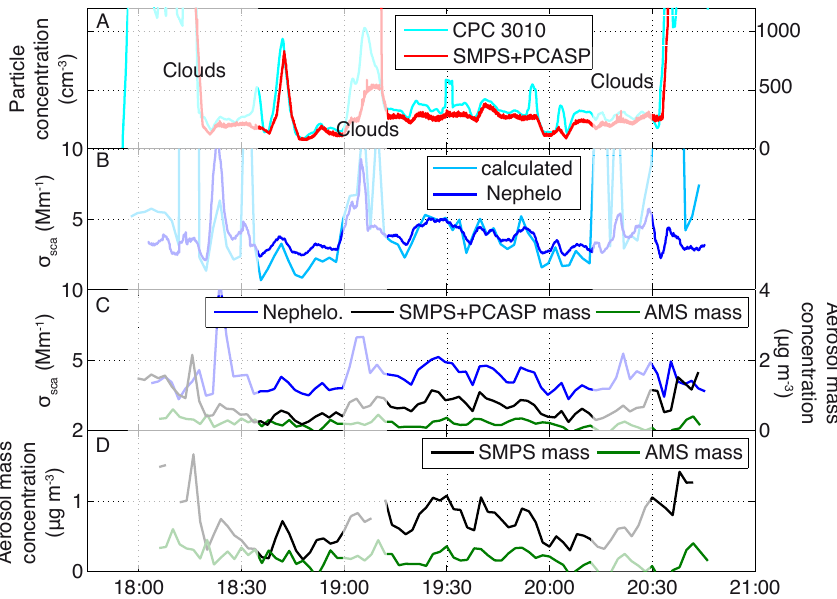
Fig. 2. Intercomparison time series for flight on 12 July: (a) total particle concentrations measured by a CPC 3010 and derived from the SMPS plus PCASP size spectra, (b) aerosol light scattering coefficent ( σ sca ) at 450nm measured by the nephelometer and derived from SMPS and PCASP aerosol number size distributions using Mie calculations, (c) measured σ sca and aerosol mass determined from the AMS and calculated from SMPS+PCASP number size distributions, and (d) aerosol mass concentrations measured by the AMS (80–1000nm vacuum aerodynamic diameter) and determined from SMPS size distributions (20–467nm mobility